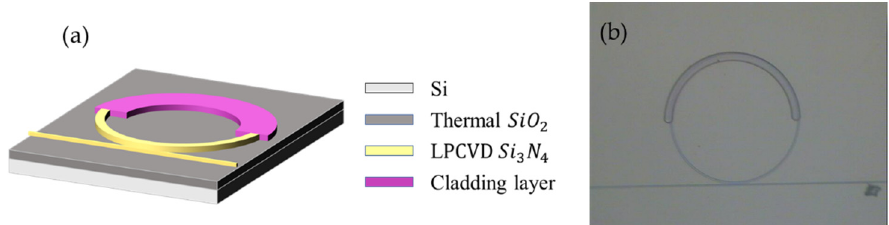
Figure 3. ( a ) The exemplary schematics and ( b ) image of the fabricated microresonator of polymer- cladding on the microresonator with 50%